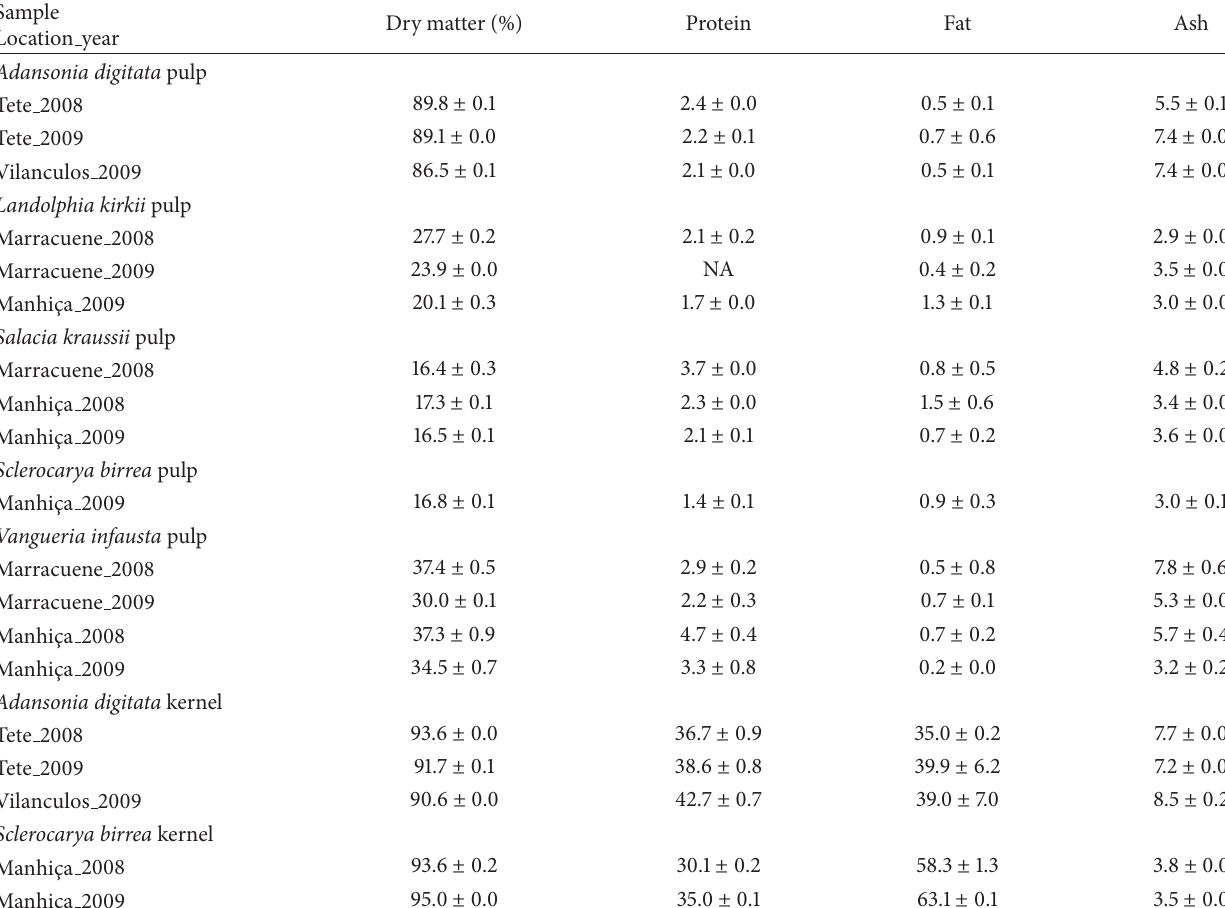
Table 1: Dry matter content, protein, fat, and ash expressed in g/100g dry matter ( 𝑛 = 3 ).